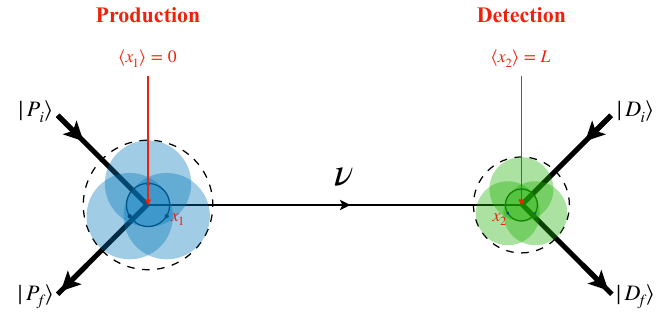
Figure 2 . A simplified Feynman diagram where the neutrino propagating a macroscopic distance is treated as a propagator of a full diagram, and the kinematics of the external particles are described with wavepackets. At the production/detection vertex site, the diameter of the shaded blue/green areas represent the uncertainties of external wavepackets projected onto the coordinate space, and their mean value is labeled as x . The inner circles with solid lines at both sites are the 1 /x 2 additional coordinate uncertainties from the blob vertices for the internal states regardless of the external particles. In other words, it represents the uncertainties of x by g ( x ) /g ( x ) in 1 /x 2 P 1 D 2 eq. (2.7). Hence the total uncertainty on the coordinate space at this layer would be the diameter of the dashed-lined